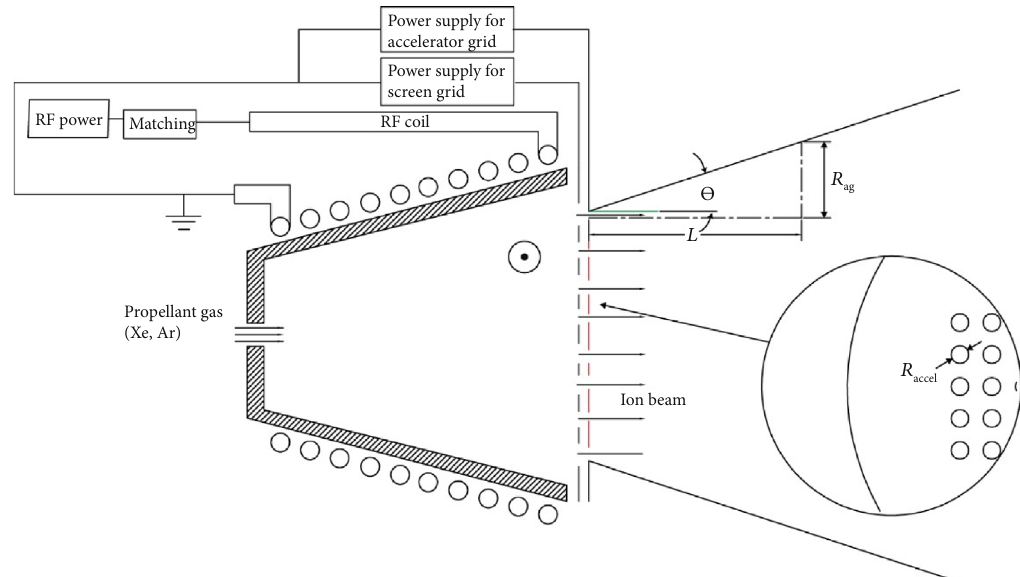
Figure 1: Schematic drawing of the RF ion